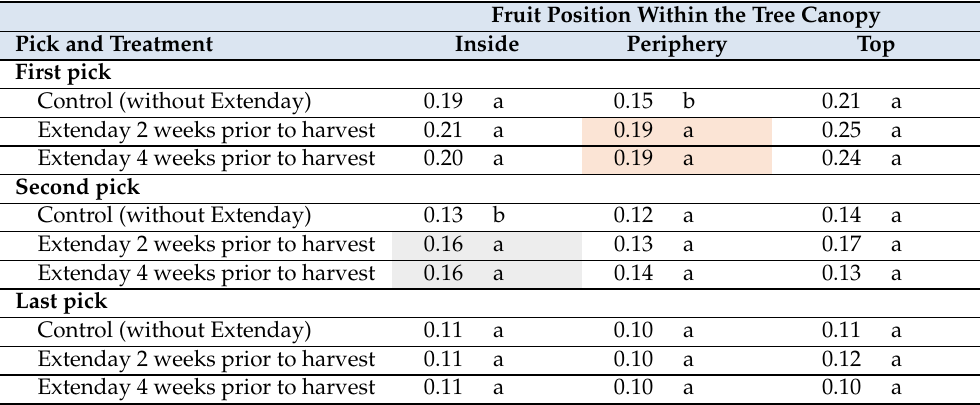
Table 3. Quality parameter (Streif index) and ripening of cv. Fuji apple at each pick dependent on fruit position within the tree canopy. Fruit Position Within the Tree Canopy Pick and Treatment